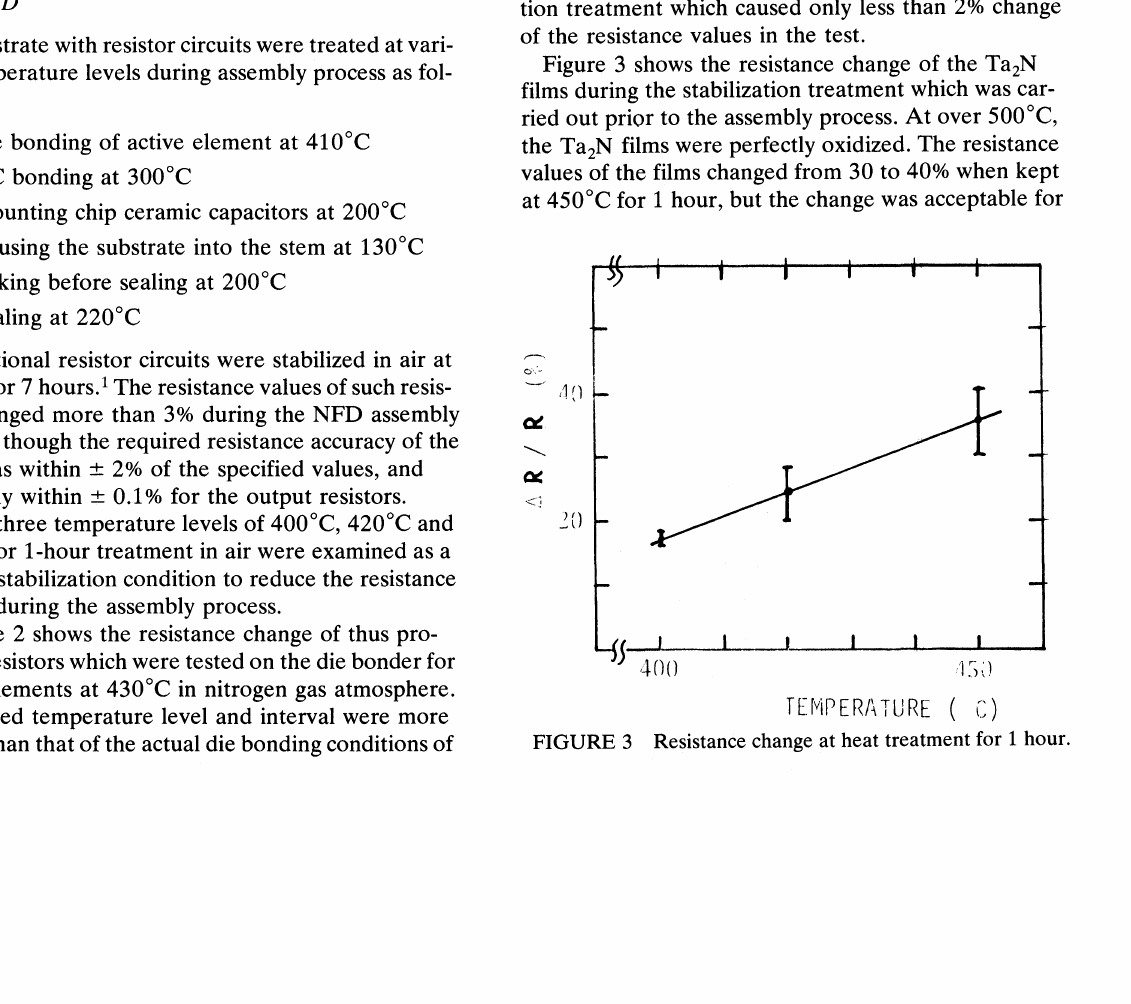
FIGURE 2 Resistance change on the die bonder at 430C in nitrogen gas atmosphere.